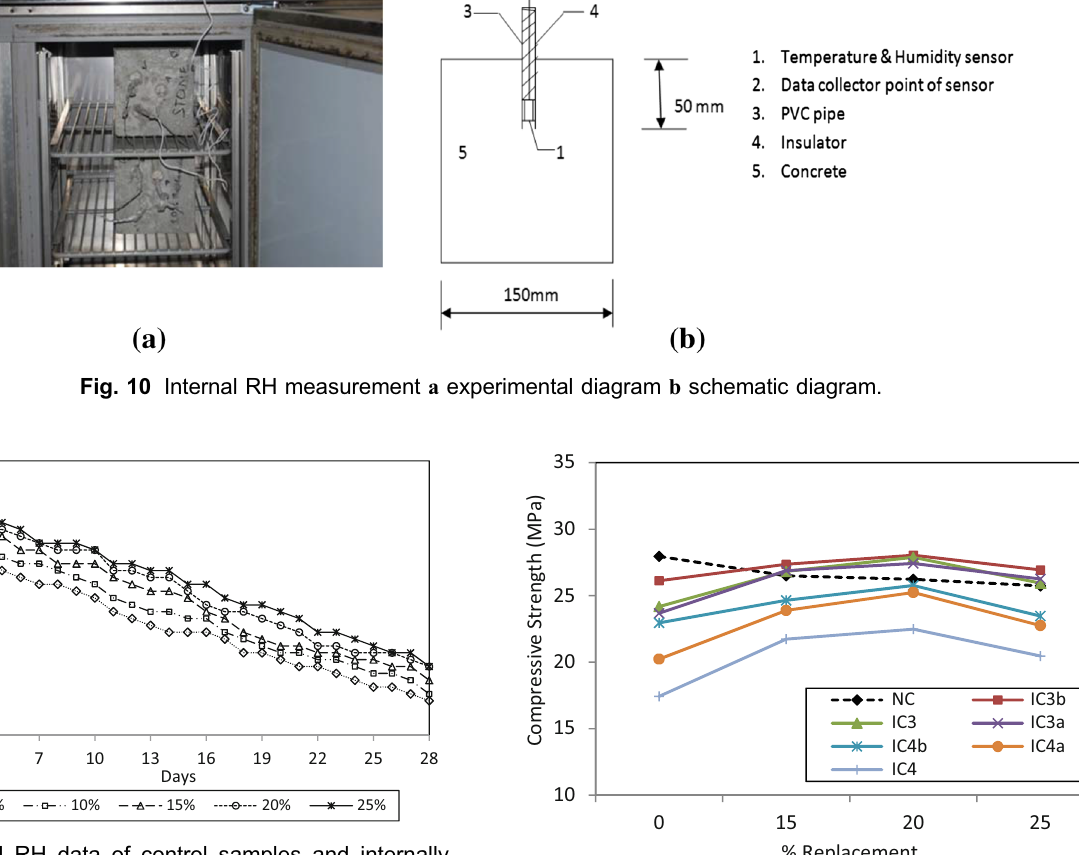
Fig. 11 Internal RH data of control samples and internally cured samples with respect to days.